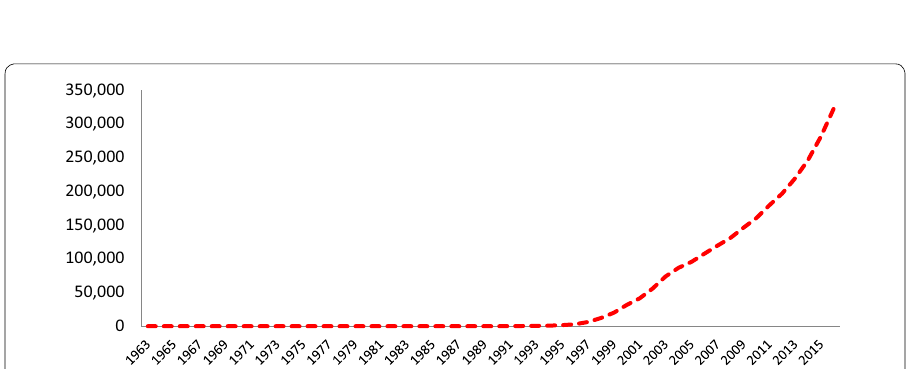
Fig. 5 Wage index (annual, 1963–2015) Source : Wage index (1990 from TurkStat (industrial sectors, statistical indicators 1923–2013) for 1963–2001. Between 2002 and 2015, wage index (1990 100) was calculated by deriving data from OECD (hourly =